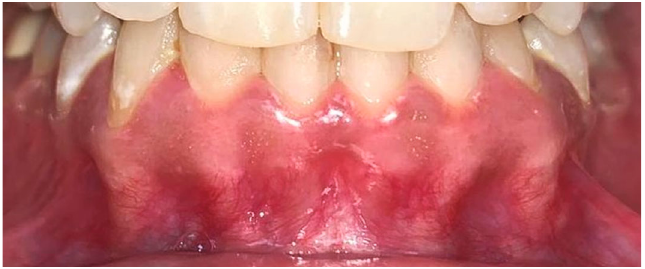
Figure 4: Recurrence of gingival pigmentation started after 6